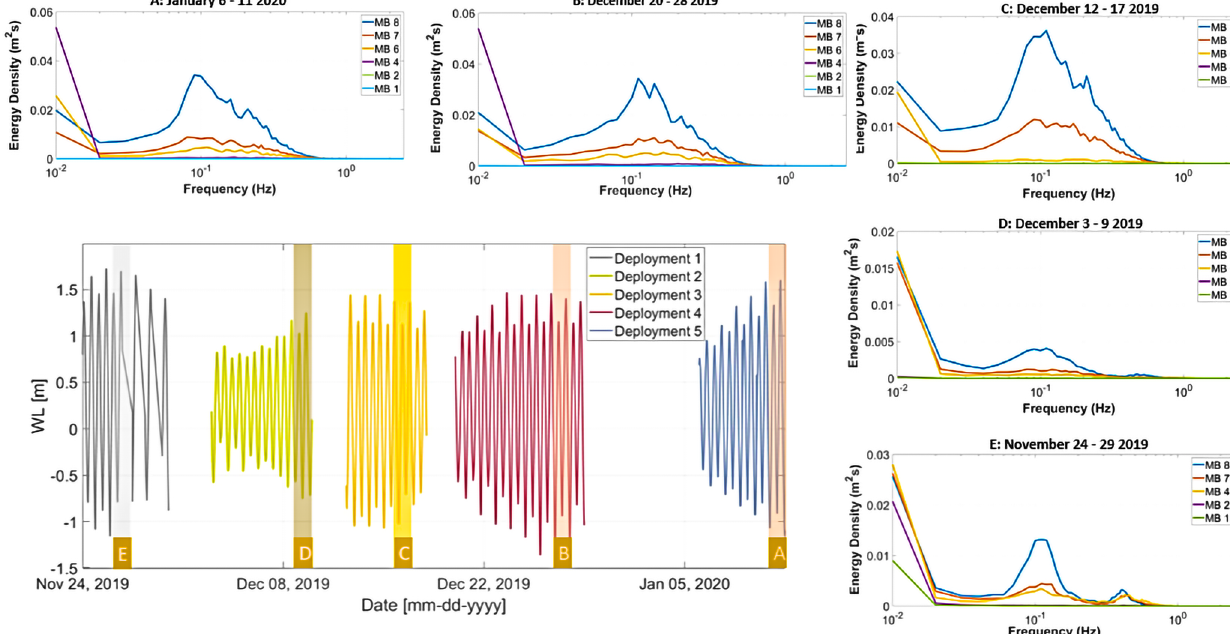
Figure 9. Averaged wave energy density spectra of simultaneously obtained wave data during full inundation of the cross-shore transect MB at Chateau Margot each for five different periods (A–E). In the lower left are tidal conditions during the field campaign. The shaded areas in the panel represent the data collection periods of the spectra. Sensor positions (MB 1–8) refer to the positions indicated in Fig.